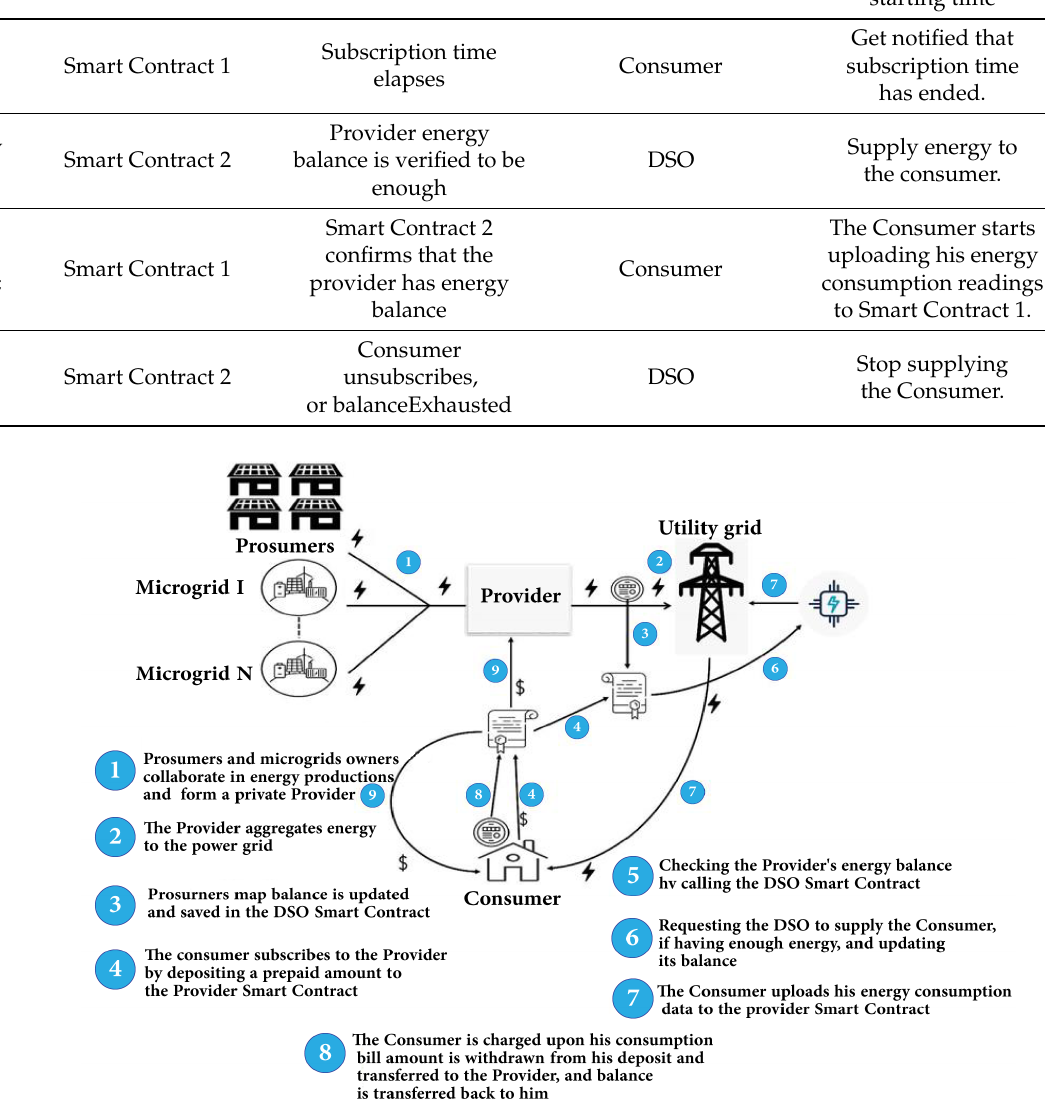
Figure 10. Interactions between the entities of the proposed P2P trading